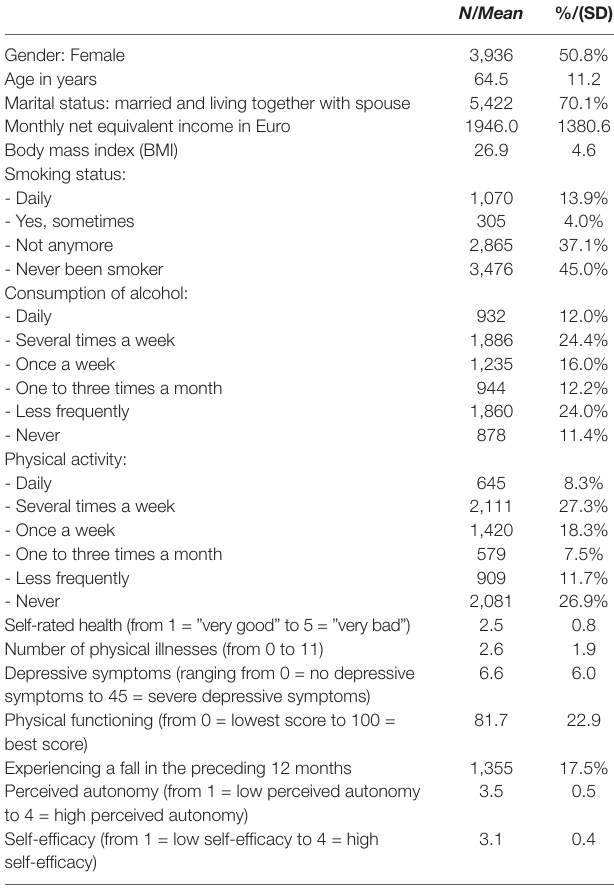
TABLE 1 | Sample characteristics (German Ageing Survey, fifth wave, n =